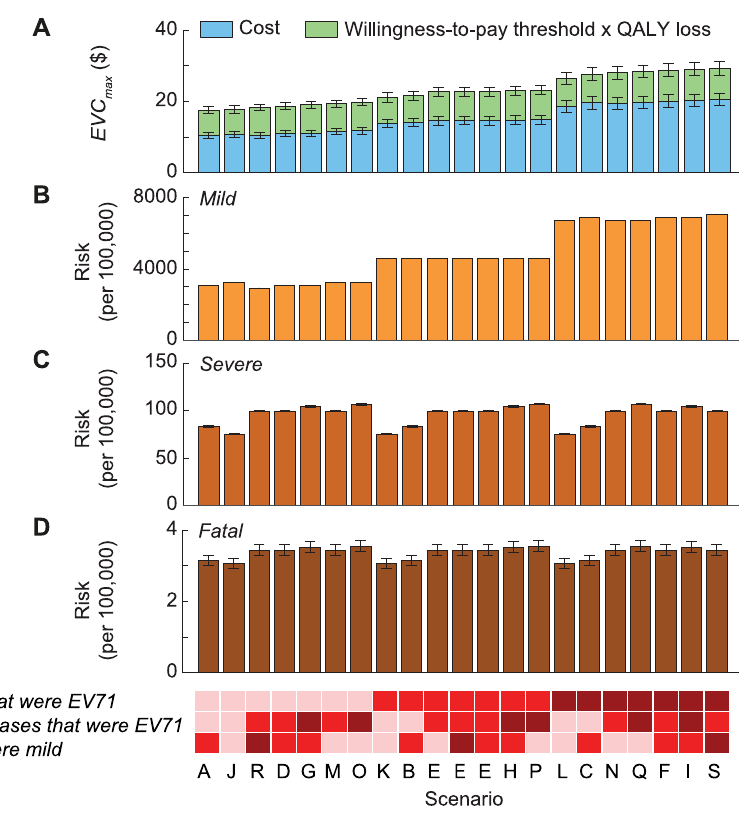
Fig 4. Cost-effectiveness of routine pediatric EV71 vaccination in China with a willingness-to-pay threshold of one times GDPpc. The 21 scenarios from Fig 2 are listed along the x -axis in ascending order of EVC max . The base case was scenario A, which had the lowest EVC max . The color shades at the bottom indicate the assumptions regarding the percentage of test-negative cases that were mild during 2010 – 2012 (bottom row), the percentage of test- negative severe/fatal cases that were EV71-HFMD (middle row), and the percentage of test-negative mild cases that were EV71-HFMD (top row) in each scenario, where darker shades correspond to higher percentages. As described in Fig 2B, three combinations of these percentages resulted in the same scenario, namely scenario E. The size of the 95% prediction intervals was driven by the parametric uncertainty associated with our estimates of the risk of EV71-HFMD and the mean cost and QALY loss attributed to EV71-HFMD in our probability sensitivity analysis (as in Fig 2B). (A) Pediatric EV71 vaccination would be cost-saving and cost-effective if EVC was below the cost of EV71-HFMD (blue bars) and EVC max (blue plus green bars), respectively. (B – D) The risk of mild, severe, and fatal EV71-HFMD in each scenario. The error bars show the 95% CIs, but in some cases they are not apparent for the risk of mild and severe